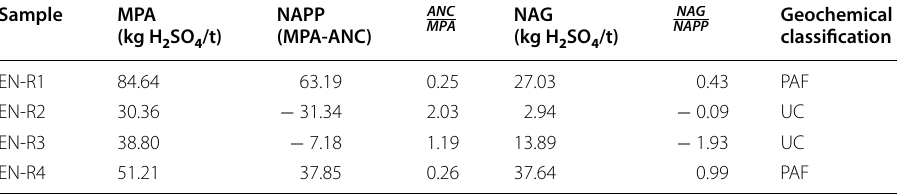
Note 1: The safety factor (ANC/MPA) is an indicator of the relative safety margin regarding acid rock drainage. Based on a safety